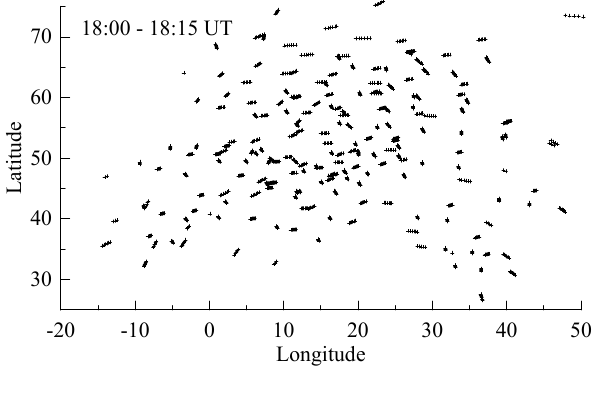
Fig. 3. The available TEC observations at 350km altitude for a 15min